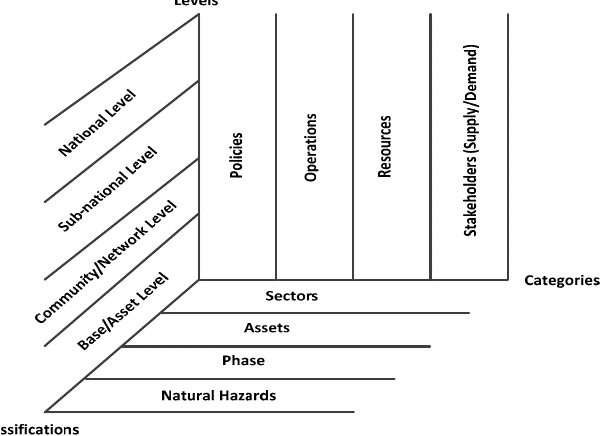
Figure 2. SoS approach for assessment of resilience in infrastructure.